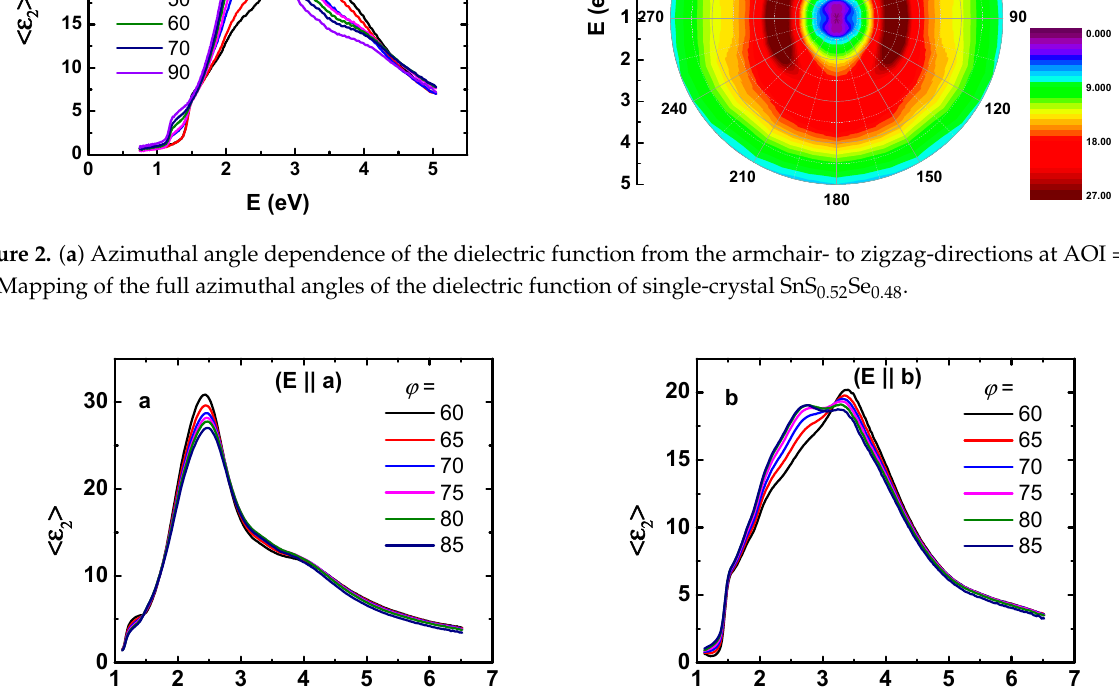
Figure 2. ( a ) Azimuthal angle dependence of the dielectric function from the armchair- to zigzag-directions at AOI = 70 ° .